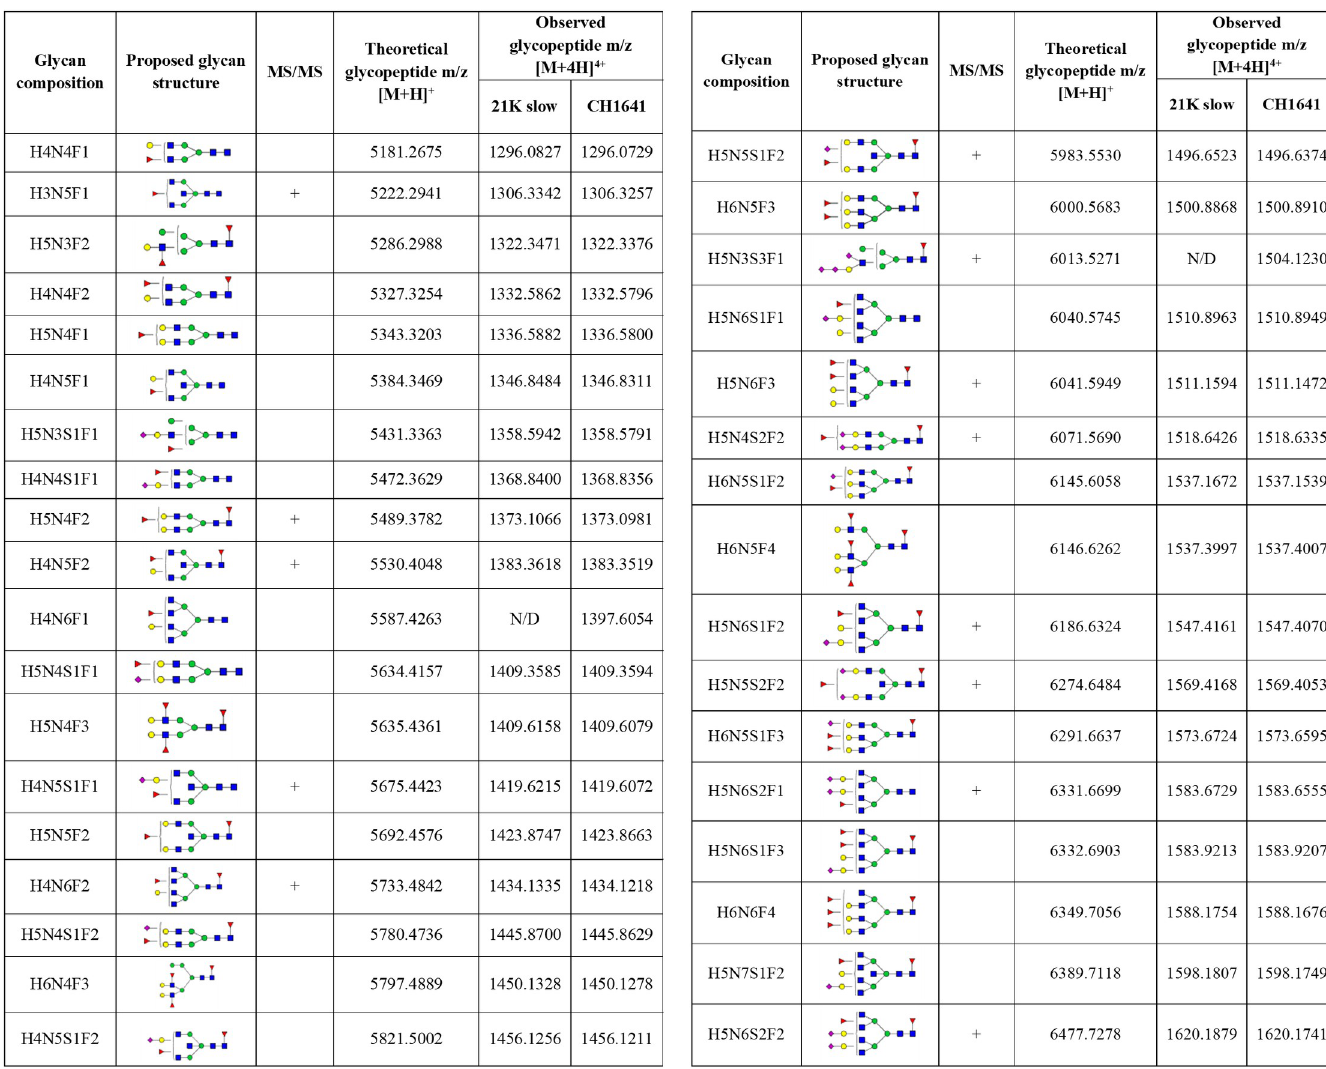
Fig 2. Detected N-184 glycopeptides on both prion strains. Proposed glycan structures found on N-184 glycosylation site with the theoretical and observed m/z values of the detected glycopeptides. H–hexose, N– N -acetylhexosamine, F–fucose and S– N -acetylneuraminic acid (sialic acid). Blue square–N-acetylglucosamine (GlcNAc), green circle–mannose (Man), red triangle–fucose (Fuc), yellow circle–galactose (Gal), purple diamond–N-acetylneuraminic acid (Neu5Ac). The presence of MS/MS spectrum is indicated with +. N/D–not determined. representing [HexNAc + H] + residue; 366.13 (+1) [HexNAcHex + H] + ; 512.19 (1+), in case of antennary fucosylation, representing [HexHexNAcFuc + H] + ; and 657.22 (1+), in case of sialy- lation, [HexNAcHexNeuAc + H] + . The peptide portion was confirmed by the presence of b and y ions, corresponding to the amino acid sequence of the N-184 peptide, together with the fragment of the peptide backbone alone 1192.22 (3+), the peptide carrying GlcNAc residue 1259.92 (3+) or carrying core fucose (GlcNAc + Fuc), with m/z value of 1308.60 (3+) (seen in Fig 4).